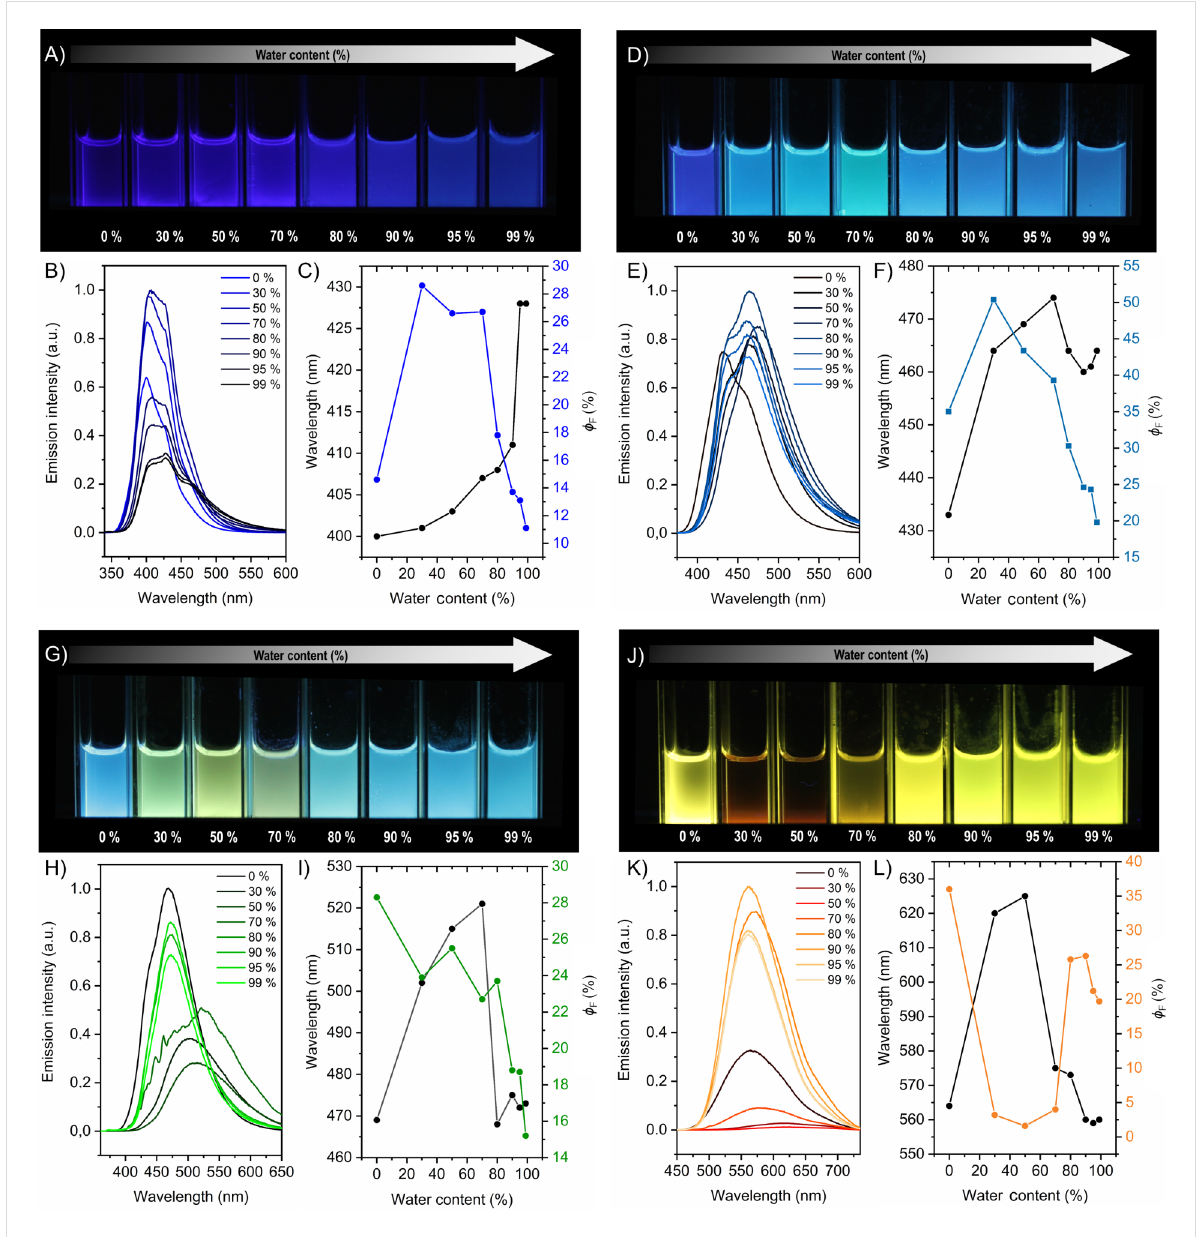
Figure 5: A) Photographs of H at different THF/H 2 O ratios under UV excitation ( λ = 365 nm). B) Photoluminescence spectra of H at different THF/water ratios. C) Emission wavelength and Φ F vs water content for H . D) Photographs of OMe at different THF/H 2 O ratios under UV excitation ( λ = 365 nm). E) Photoluminescence spectra of OMe at different THF/water ratios. F) Emission wavelength and Φ F vs water content of OMe . G) Photographs of SMe at different THF/H 2 O ratios under UV excitation ( λ = 365 nm). H) Photoluminescence spectra of SMe at different THF/water ratios. I) Emission wavelength and Φ F vs water content of SMe . J) Photographs of NMe 2 at different THF/H 2 O ratios under UV excitation ( λ = 365 nm). K) Photoluminescence spectra of NMe 2 at different THF/water ratios. L) Emission wavelength and Φ F vs water content of NMe 2 . Concentrations in all cases: 10